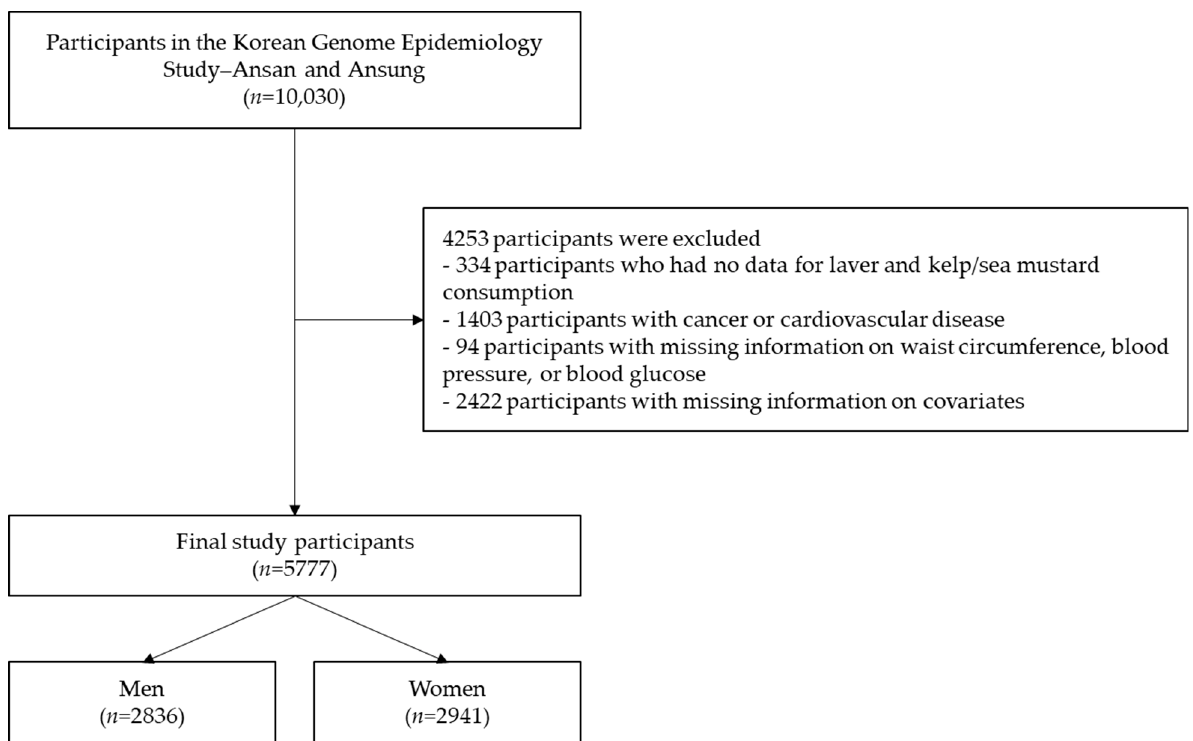
Figure 1. Process flowchart outlining the steps of this analysis.